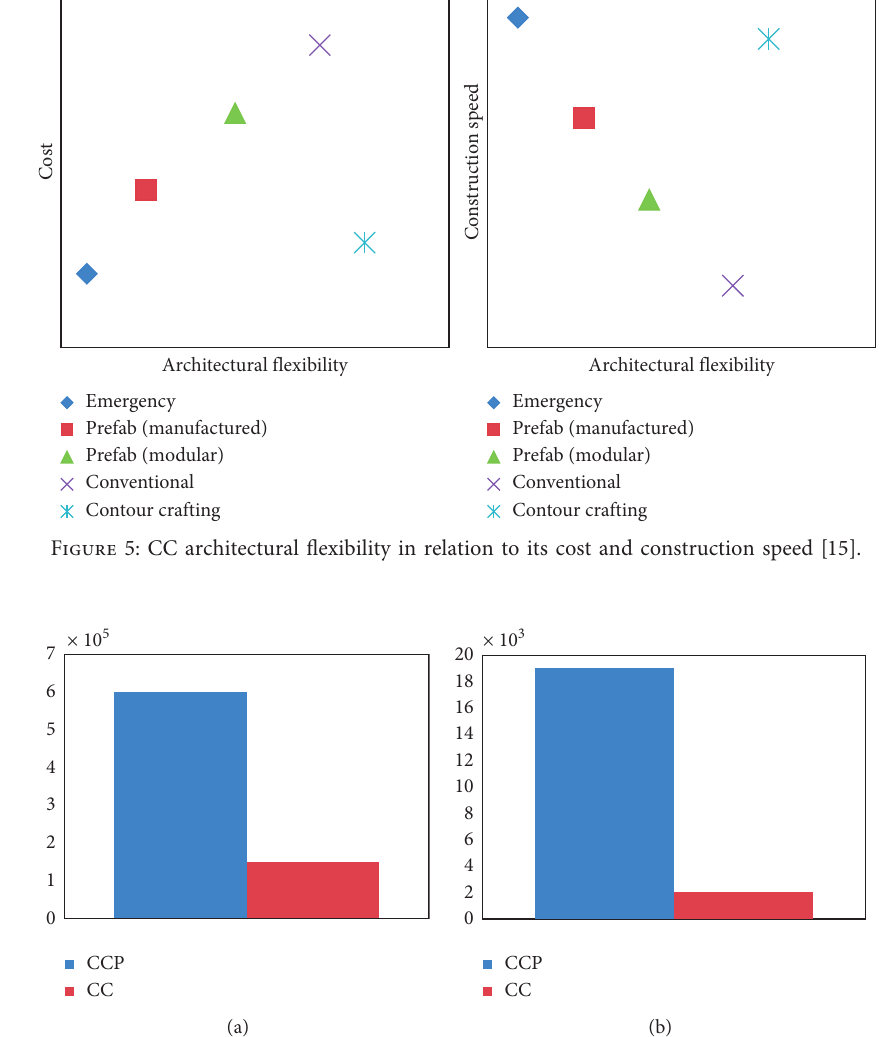
2 emission; (b) embodied